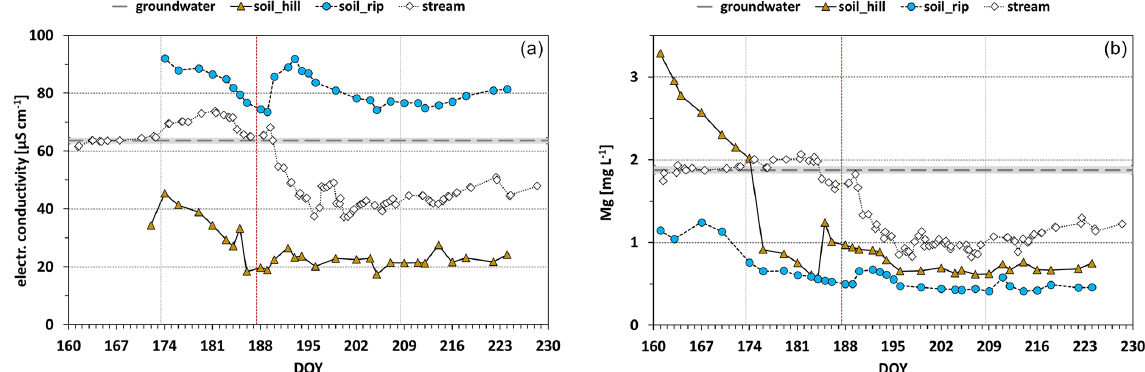
Figure 4. Time series of electrical conductivity (a) and magnesium (b) in streamflow and in the end-members’ hillslope soil water (soil_hill) and riparian-zone soil water (soil_rip). For the groundwater end-member, the mean of baseflow concentrations during the pre-monsoon period (DOY 160–173) is shown, and the standard deviation ( n = 11) is a gray band. Vertical dashed gray lines separate the four monsoon periods (see also Fig. 2). The dashed red line signifies the onset of the main period of the monsoon.